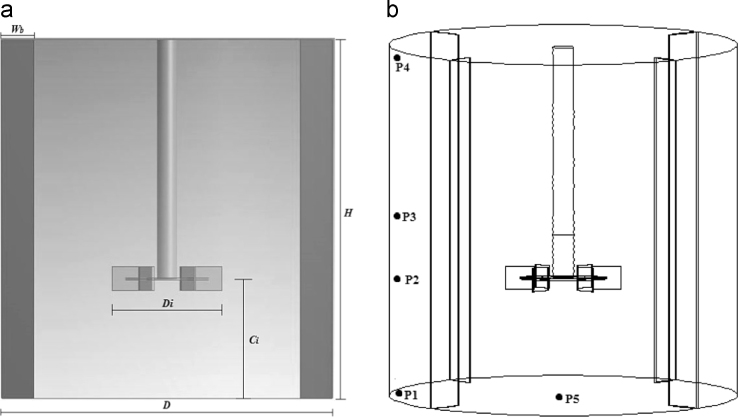
(a) Geometry of cylindrical tank, (b) the detail of locations in a tank: P1 (0.313, 0.05), P2 (0.313, 0.209), P3 (0.313, 0.3135), P4 (0.313, 0.62) and P5 (0.0, 0.0) (all measuring locations in (r, z) coordinate system).